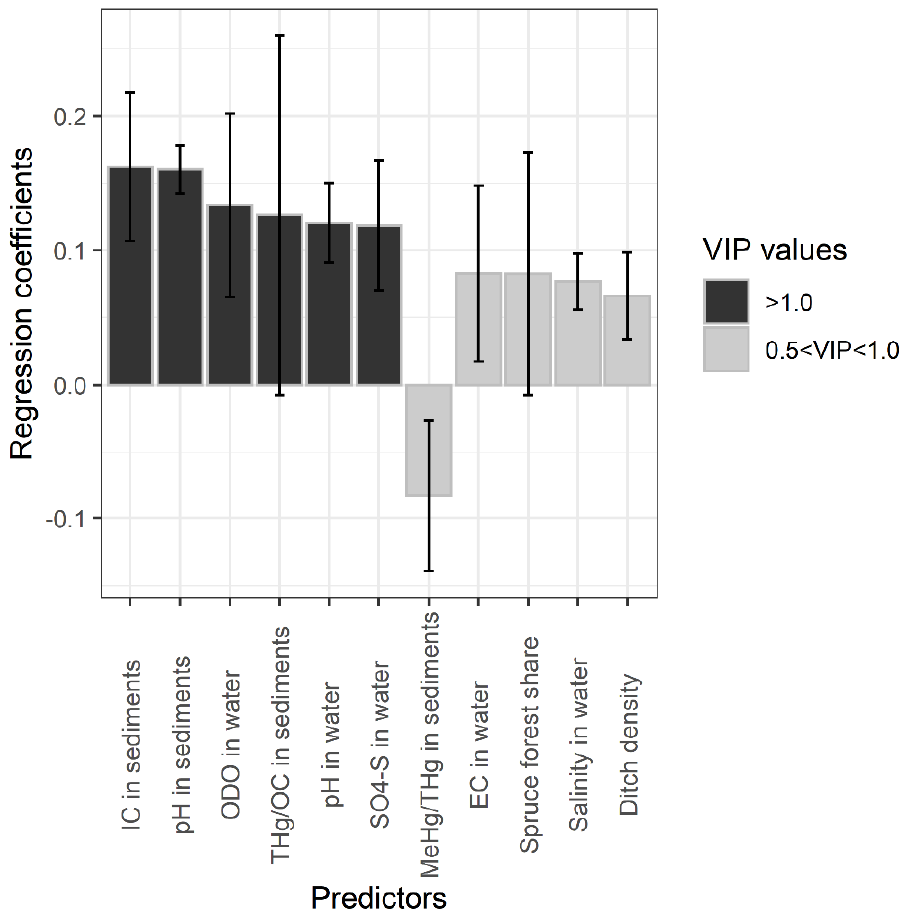
Figure 5. The PLS regression coefficients (±S.E.) showing the most influential descriptor variables (predictors) on the mean annual MeHg concentration in small watercourses of drainage systems (the spatial dataset). EC—electrical conductivity, IC—inorganic carbon, OC—organic carbon, ODO—optical dissolved oxygen.